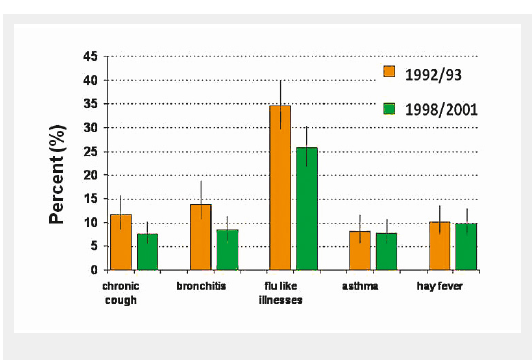
Decrease of PM 10 from 1991 to 2002 and age-related loss of lung function in Swiss adults in the SAPALDIA study [13]. An increase in air quality of 10 µg PM 10 × m –3 diminished the age-related loss of